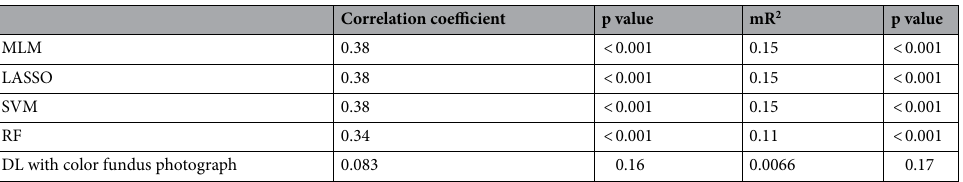
Table 5. The correlation coefficient and mR 2 values of these variables. mR 2 marginal R-squared value (following a method proposed by Nakagawa and Holger 29 ), MLM multivariate linear regression, LASSO least absolute shrinkage and selection operator regression, SVM support vector machine, RF random forest, DL deep learning.